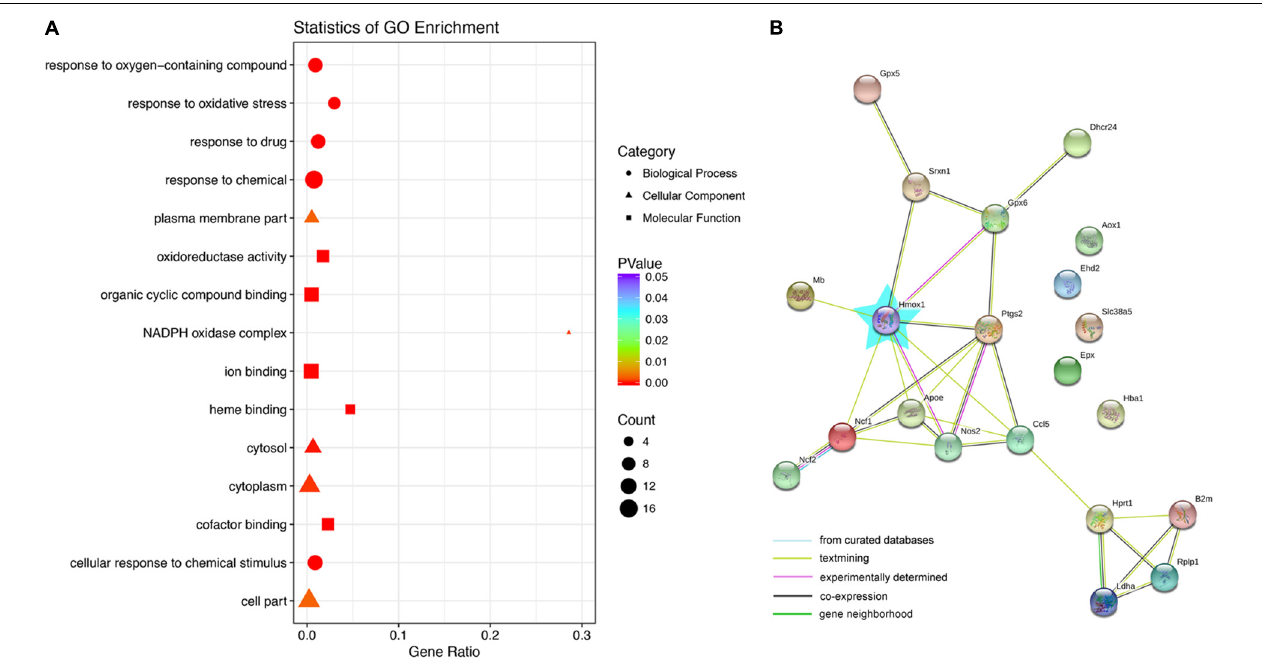
FIGURE 2 | Gene ontology (GO) and network analysis of genes with differential expression between the control and gentamicin groups. (A) GO analysis of genes with differential expression between the control and gentamicin groups. (B) STRING protein-protein interaction analysis of genes. The blue star represents Hmox1 (HO-1).